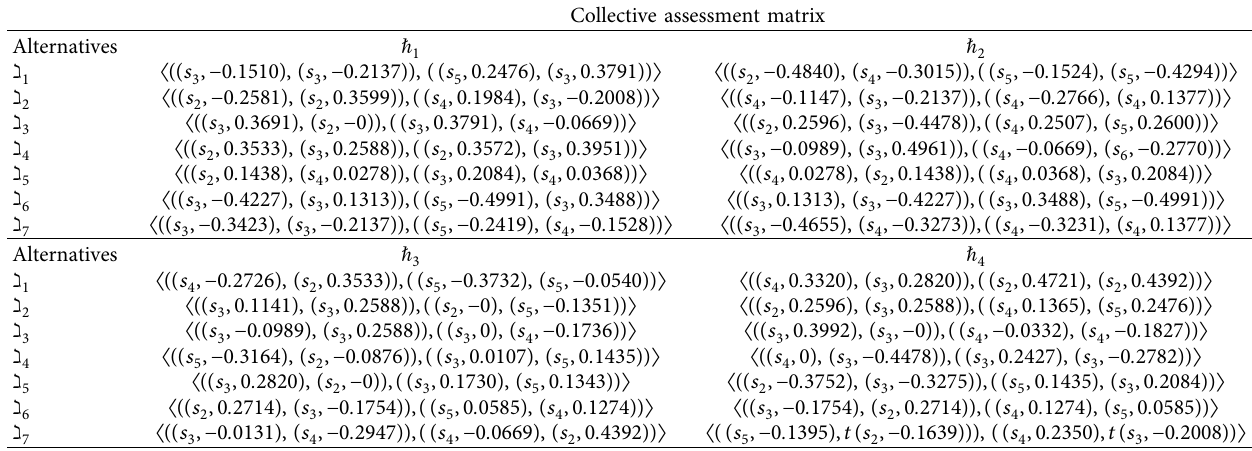
Table 8: Collective 2TLC q -ROF assessing matrix by the 2TLC q -ROFHWG operator. Collective assessment